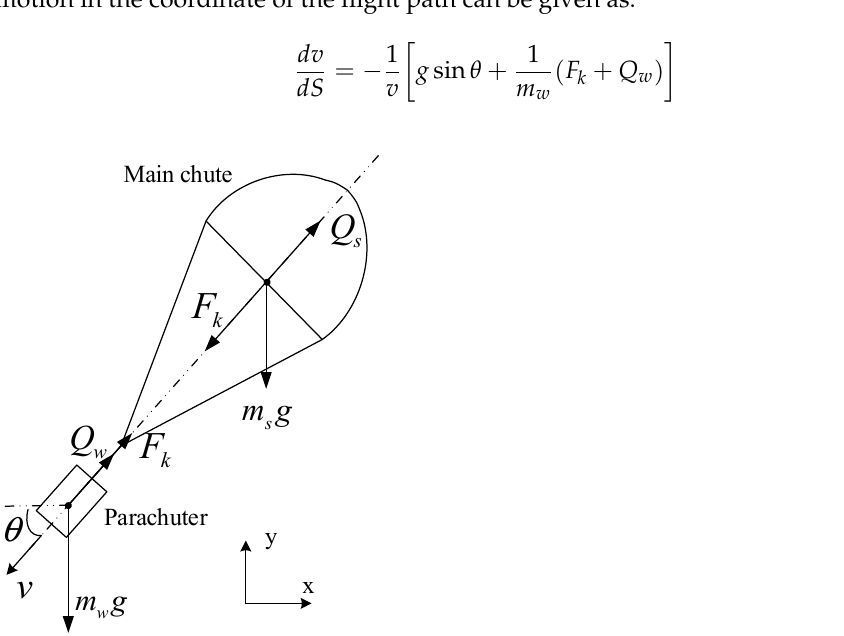
Figure 2. Schematics of the parachute inflation and descent process. Here, S is the distance of the parachute pass. The dynamic load F k is: